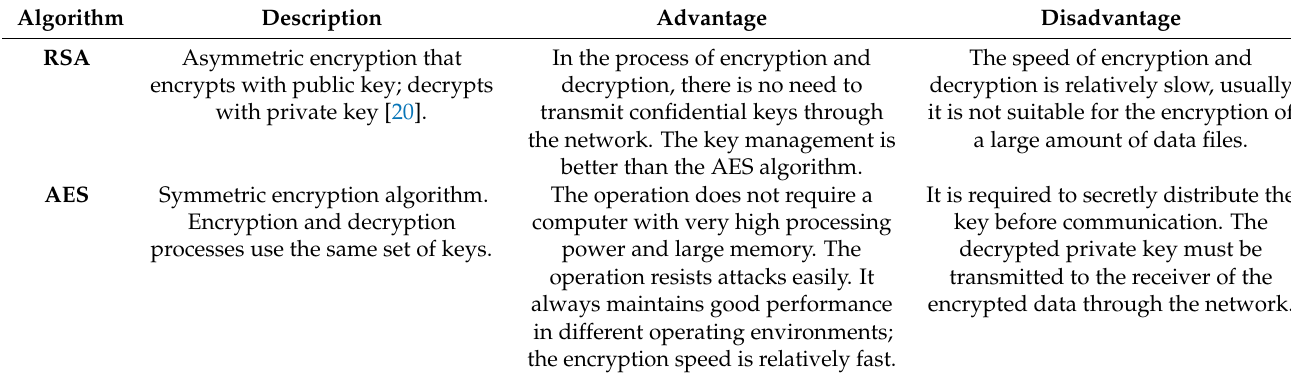
Table 2. Comparison of the four key